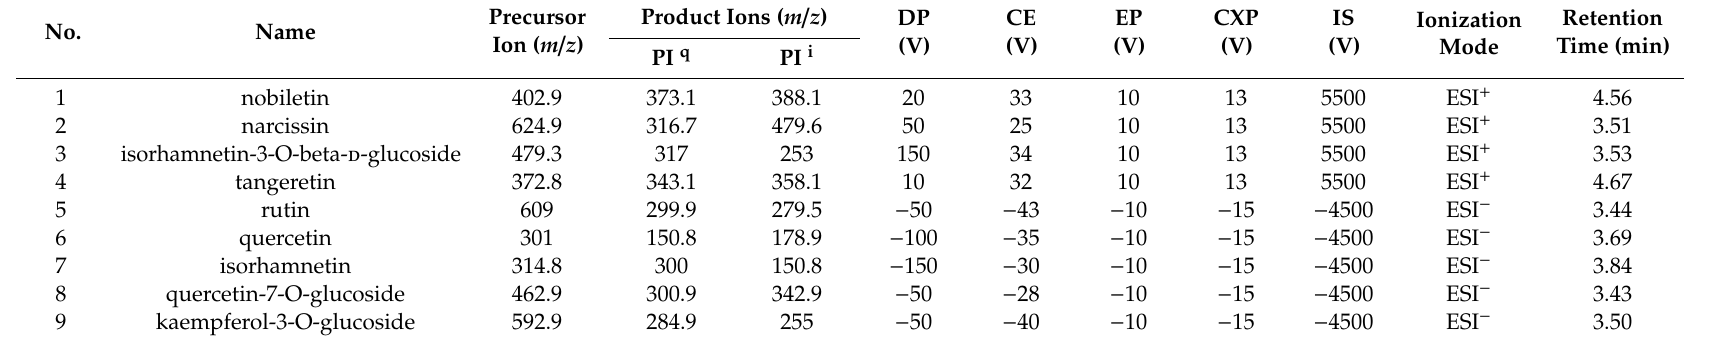
Table 2. The optimized parameters for nine flavonoid standards by HPLC-MS / MS.